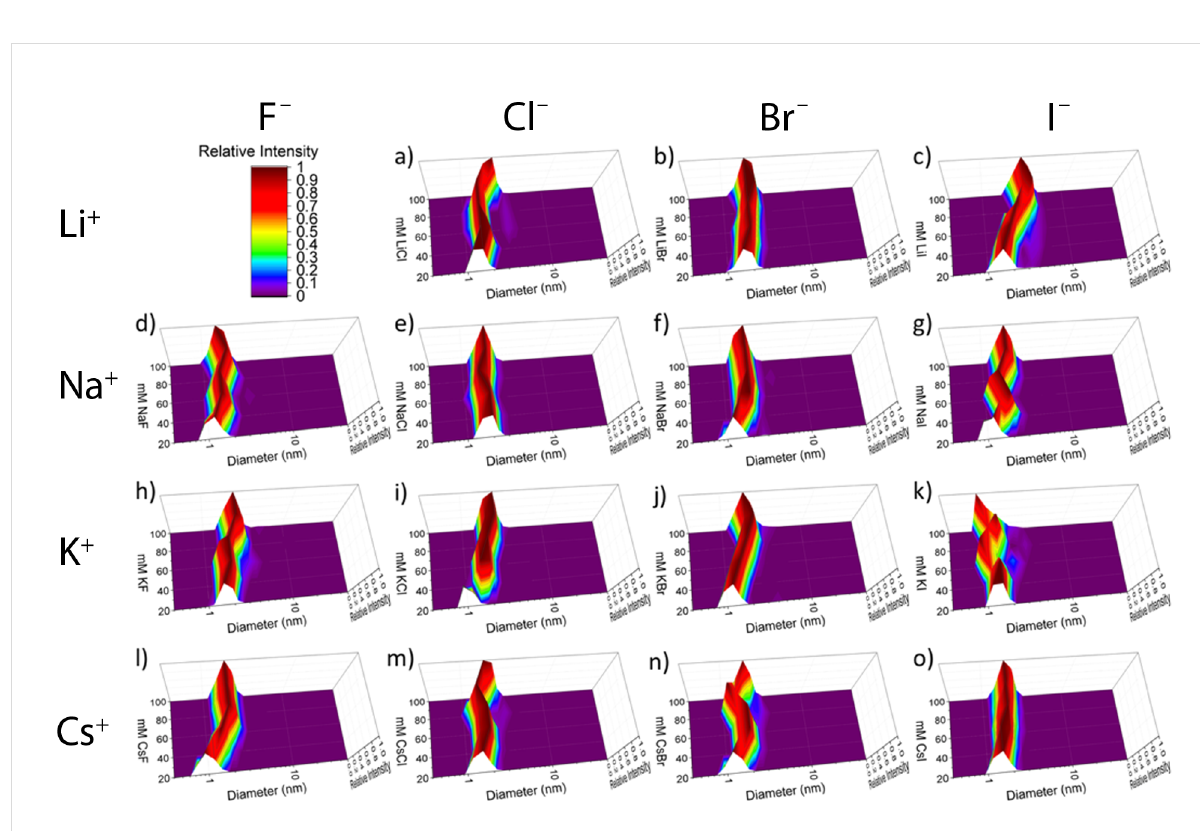
Figure 2: Representative plots of the volume-weighted distribution obtained by DLS for salts titrated into 2.00 mM 1 : a) LiCl, b) LiBr, c) LiI, d) NaF, e) NaCl, f) NaBr, g) NaI, h) KF, i) KCl, j) KBr, k) KI, l) CsF, m) CsCl, n) CsBr, o) CsI. Scale shown in the upper-left corner. The x -axis represents hydrodynamic diameter, the y -axis the concentration of the respective salt (mM), and the z -axis the relative